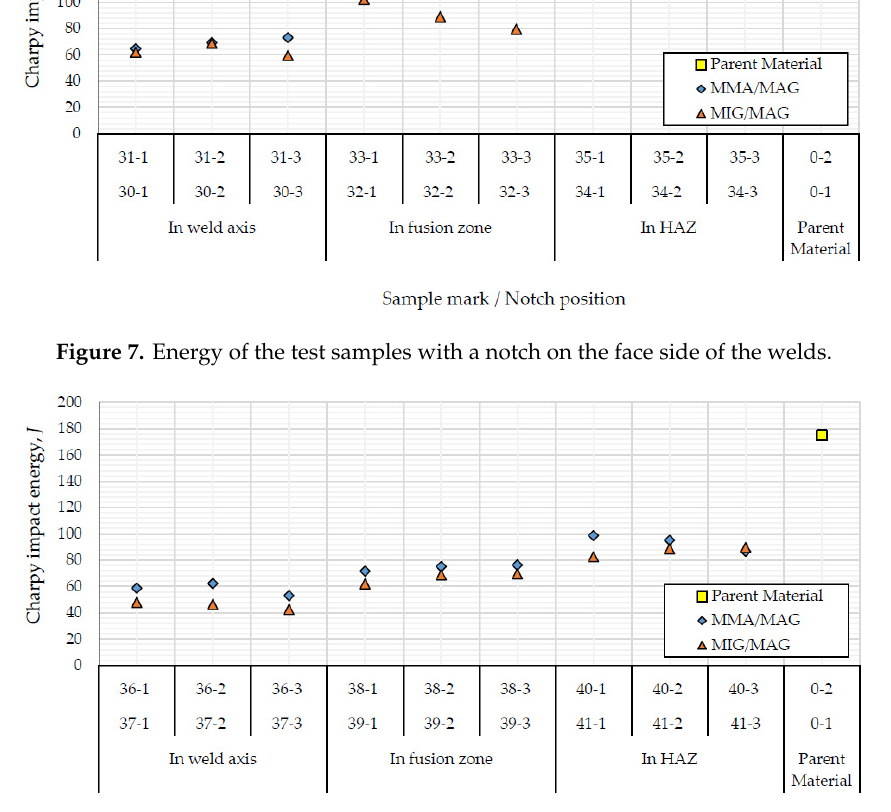
Figure 7. Energy of the test samples with a notch on the face side of the